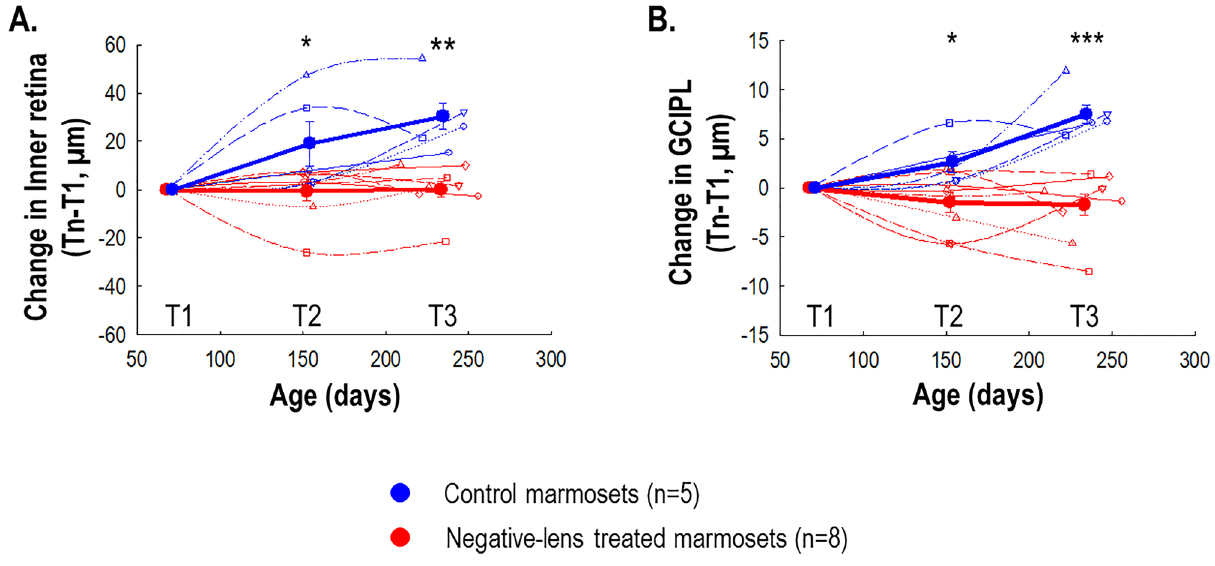
Figure 8. Thickness changes in the inner retina ( A ) and GCIPL ( B ) for control and negative-lens treated marmosets normalized to baseline over 22 weeks of treatment (T1: baseline, T2: 12 weeks of treatment, T3: 22 weeks of treatment). Thin symbols and lines represent data for each marmoset. Thick symbols and lines represent data for each treatment group. The untreated control group ( n = 5) is shown with blue circles, and the negative-lens treated group ( n = 8) is shown with red circles. Positive and negative values on the ordinate represent retinal thickening and thinning relative to baseline, respectively. Statistically significant difference at each treatment time point is indicated by * p < 0.05, ** p < 0.01 and *** p < 0.001. The data are shown as mean ± SE.